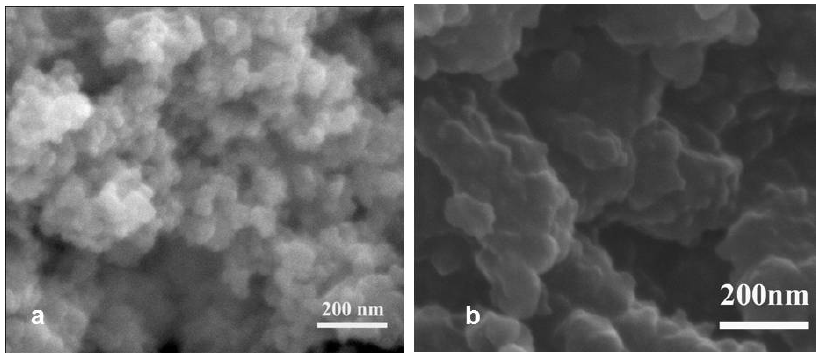
(a) and CuP-TiO 2